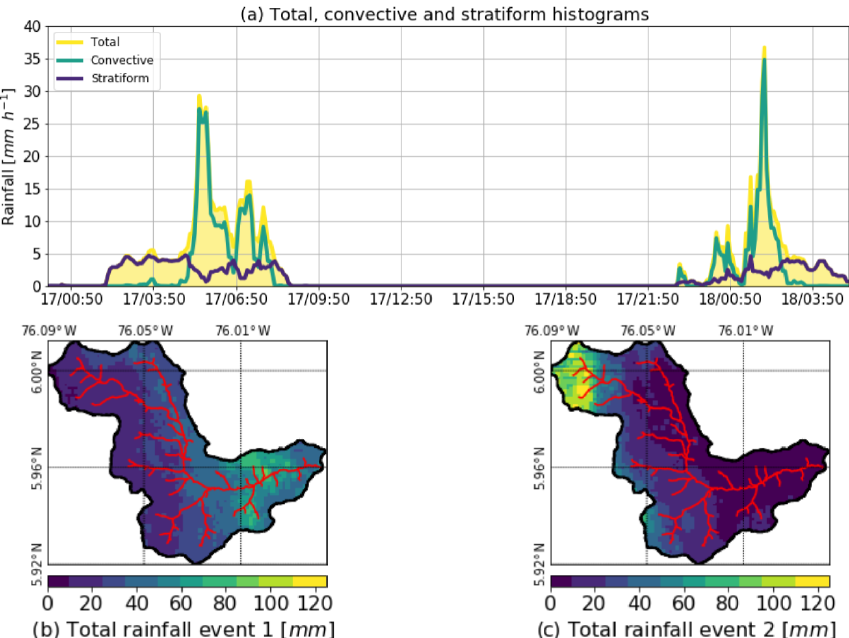
Figure 5. (a) Temporal evolution of the convective–stratiform rainfall partitioning during both Events 1 and 2 (precipitation intensity in mmh − 1 , for 5min periods). The figure shows the total rainfall (yellow) and the convective (blue) and stratiform (green) portions integrated over La Liboriana basin. (b, c) Spatial distribution of the cumulative rainfall during Events 1 and 2 over La Liboriana basin,